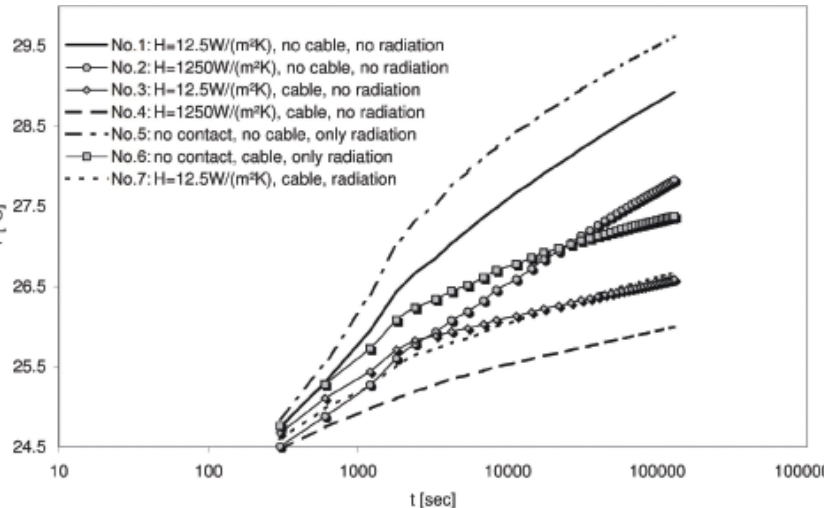
Fig. 18. Temperature response of the LNP03-sensor (short thick needle) at the measurement point due to heating in a low conductivity sample with λ = 0 . 02Wm − 1 K − 1 .